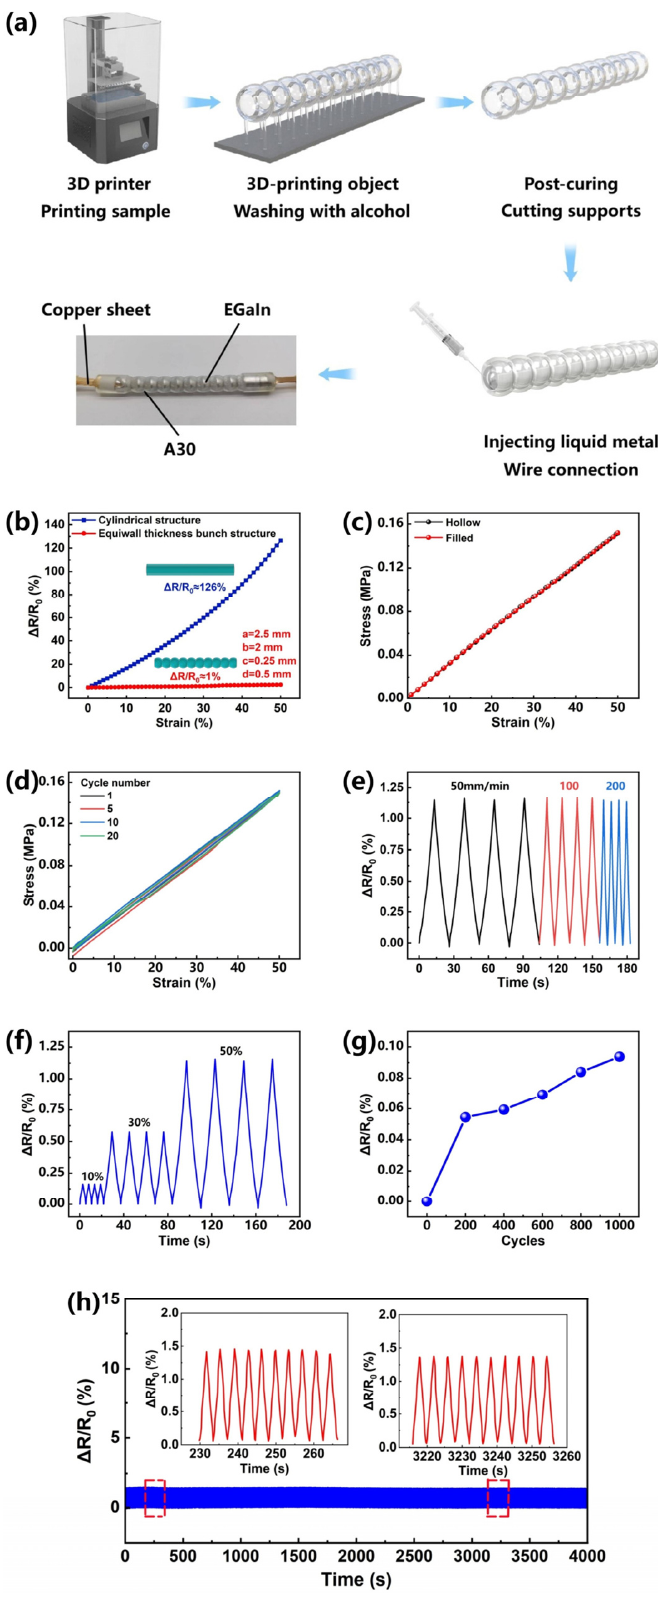
Figure 3. Three-dimensional-printing process and performance of string structure wire. ( a ) Fabrica- tion process. The elastic matrix of the equiwall-thickness linear bunch structure was made by a 3D printer, and the structure was filled with liquid metal. ( b ) Comparison of the resistance change of the strain-insensitive equiwall-thickness bunch structure conductor with the ordinary cylindrical pipe during stretching, through the optimization of structural parameters. ( c ) Comparison of me- chanical properties of bunch-structured stretchable conductors filled with liquid metal and unfilled